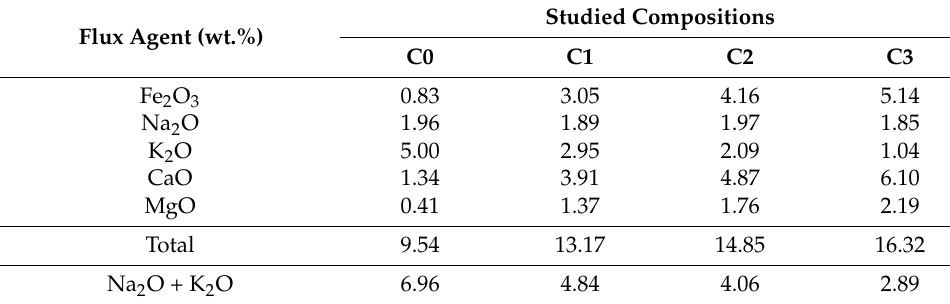
Table 4. Flux agent composition by XRF of the studied compositions. Flux Agent